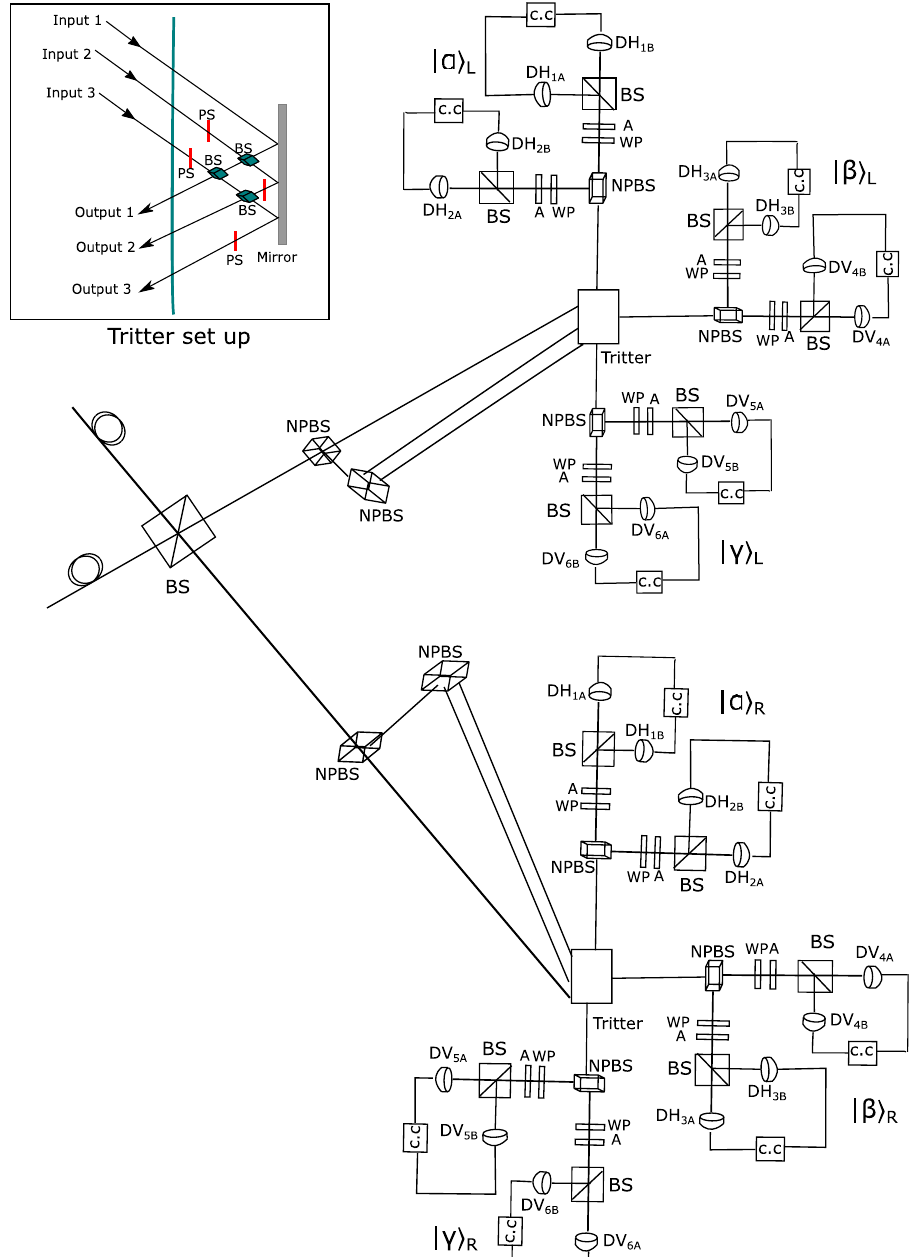
Figure 3. Illustration of the measurement set up at Charlie’s site. The incoming biphotons interfere in the beam-splitter (BS) and exit through either of two output ports towards the two non-symmetric beam-splitter (NPBS), where they are further split into three channels and directed towards the tritter. The tritter setup shown in the upper left is a three-input-output port splitter. It comprises three conventional beam-splitters (BS), four- phase shifters (PS), and a mirror. The output ports of the tritter are linked with three Brown Twiss schemes for β γ α detecting the three basic states , , and . Each Brown Twiss scheme consists of a non-symmetric beam- | � | � | � splitter (NPBS), wave plates (WP), polarization analyser (A), and detectors (D P i ) where P polarization mode and subscript i denotes single photons forming biphotons. The abbreviation c.c corresponds to coincident counting or